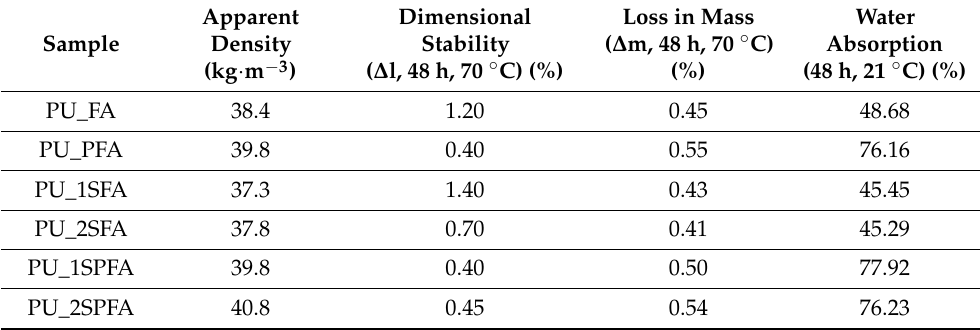
Table 3. Results of apparent density, dimensional stability and water absorption of RPUFs.